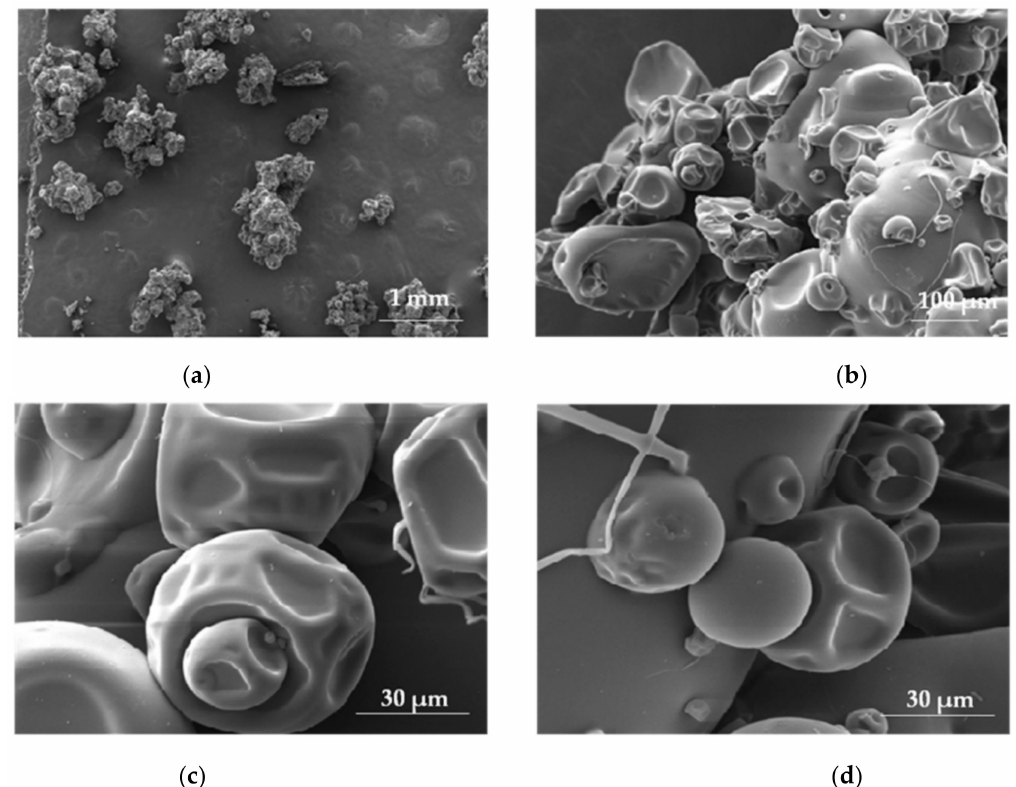
Figure 3. SEM illustration of pregelatinized pea starch (Lycoat RS 720) under magnification: ( a ) 100 × , ( b ) 1000 × , ( c , d ) 5000 × (photographs of the authors made with Inspect™S50, FEI Company, Hillsboro, OR, USA).